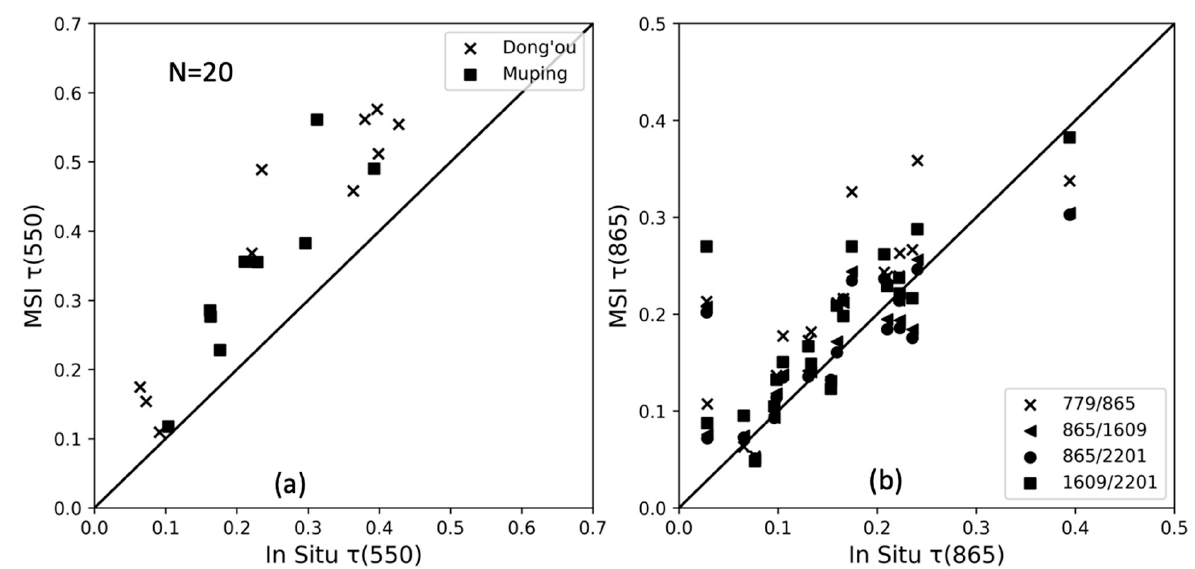
Figure 16. Validation of MSI-derived aerosol optical depth ( a ) at 550 nm, τ (550), using ACOLITE and ( b ) at 865 nm, τ (865), using SeaDAS with four band combinations (779/865, 865/1609, 865/2201, and 1609/2201).